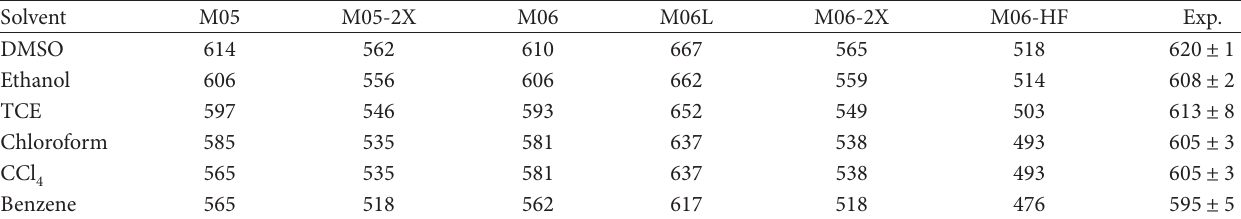
T 1: Maximum absorption wavelengths of the indigo molecule (in nm) calculated using the Minnesota density functionals in several